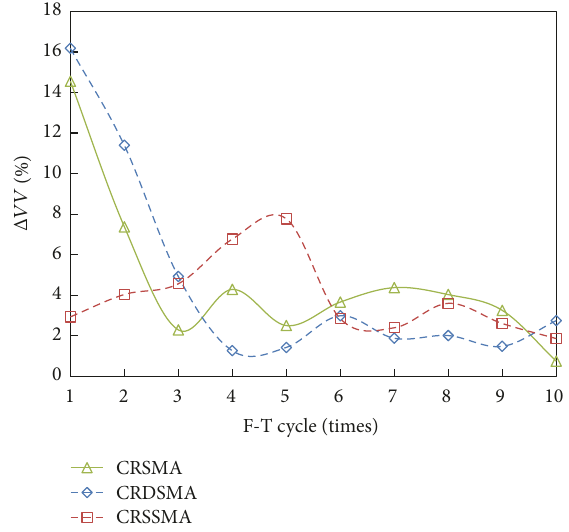
Figure 5: Change ratio of air void for CRSMA, CRDSMA, and